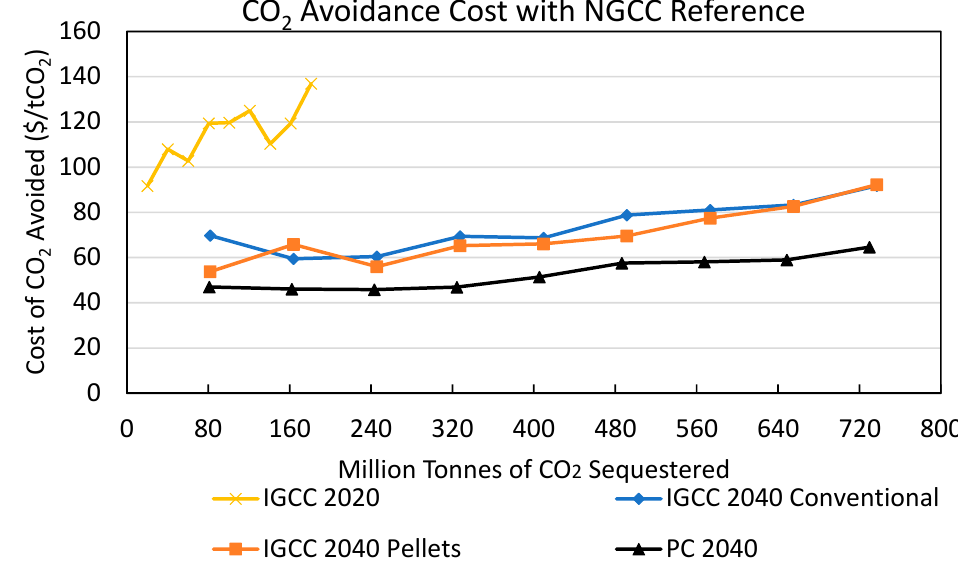
Figure 10. BECCS scenario-average CO 2 avoidance costs (CAC) ($ per tonne CO 2 ) by CO 2 sequestered (million tonnes per year) under the natural gas combined cycle reference scenario, net after supply chain emissions for the four BECCS scenarios: 2020 IGCC conventional, 2040 IGCC conventional, 2040 PC pellets, and 2040 IGCC pellets. “Conventional” refers to biomass handled as chips or bales; “pellets” refers to biomass converted to pellets in process depots.